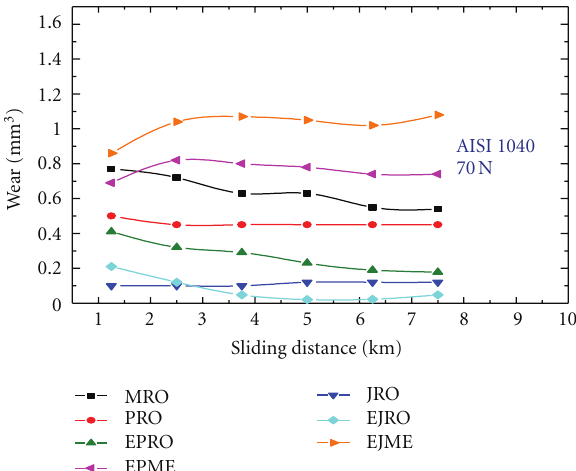
Figure 5: Variation of wear with sliding distance for 70 N.